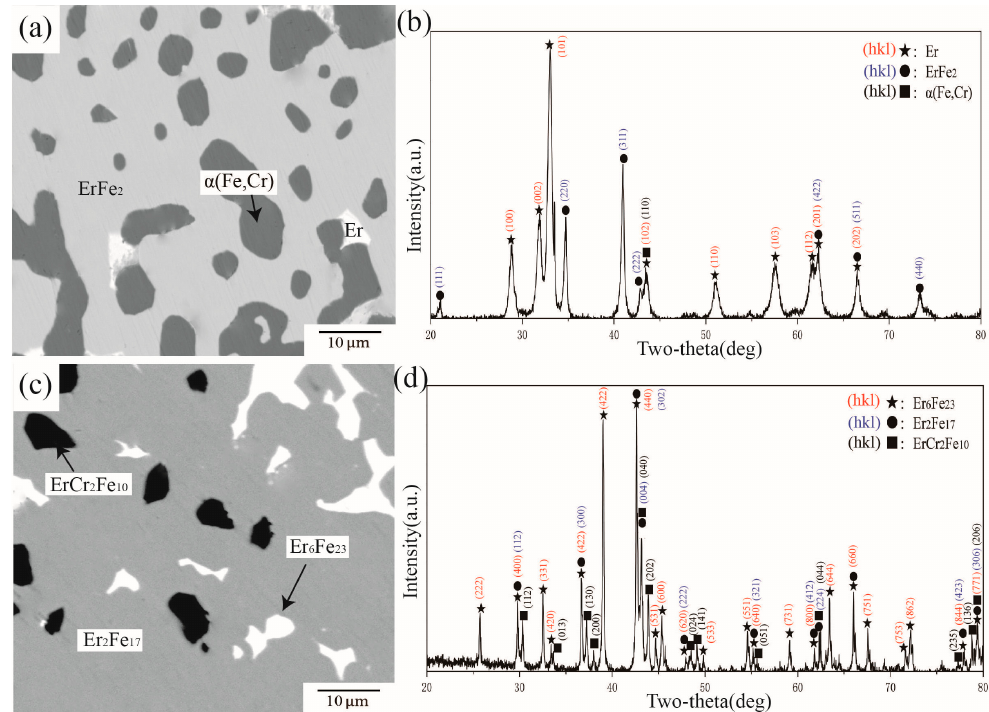
Figure 9. ( a ) BSE image of alloy A8, ( b ) XRD result of alloy A8, ( c ) BSE image of alloy A12, ( d ) XRD result of alloy A12.